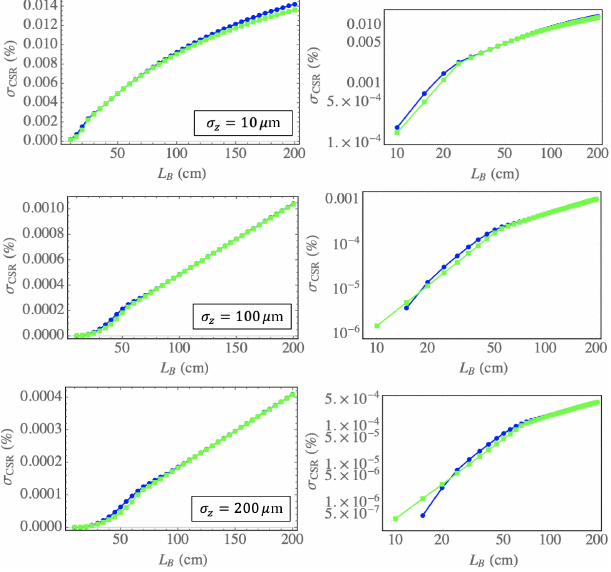
FIG. 5. The CSR rms energy spread for various initial bunch lengths traversing a bend of various bend lengths and constant bend curvature ( ρ ¼ 10 m). Left column: The CSR rms energy spread from ELEGANT (blue) and Eq. (13) (green). Right: Log-Log plot of the CSR rms energy spread.